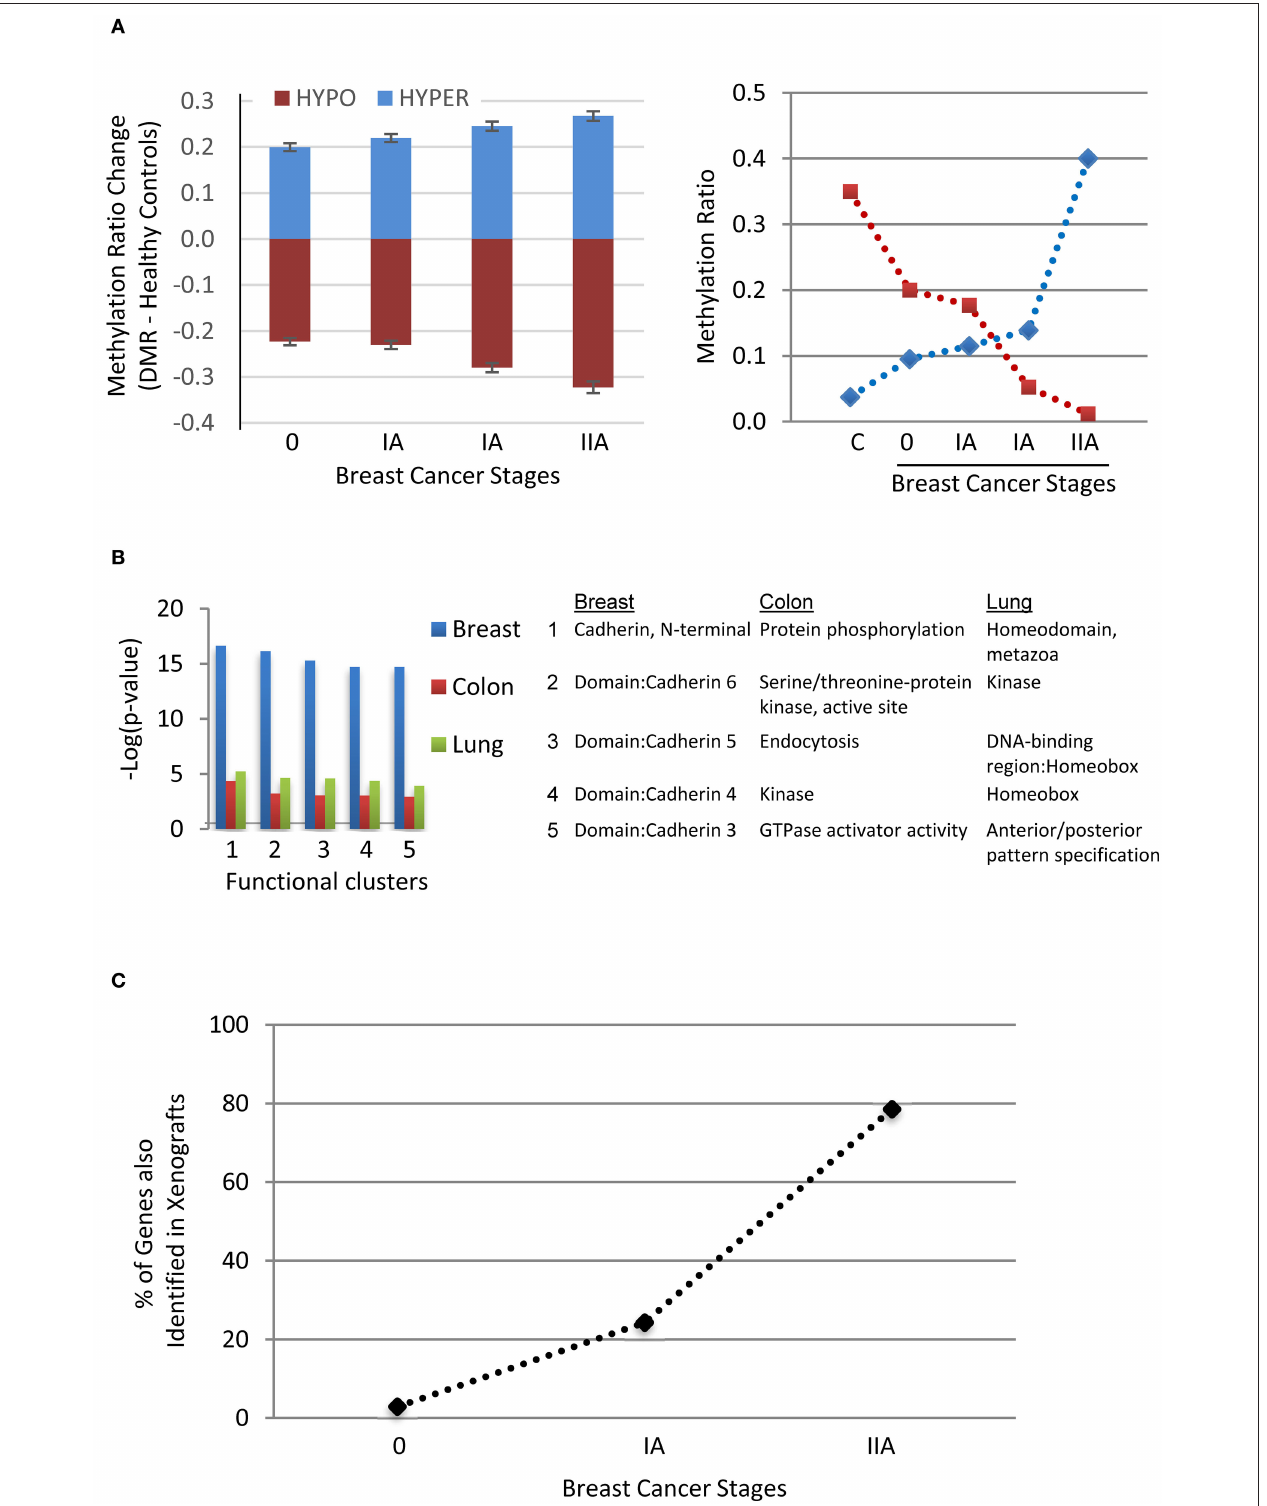
FIGURE 5 | Evidence supporting the association of the DMRs with tumorigenesis. (A) Stage-dependent methylation changes of breast cancer-specific DMRs (Mean ± SEM, n = 314, Left panel) compared to the mean of healthy controls (C) and two examples of hyper- or hypo- methylation from stage 0 to stage II with two samples at stage IA. (B) Top five DAVID functional clusters of the cancer-specific DMR-associated human genes of the three types of cancers. (C) Percentages of identified genes shared ( n = 34) between the human breast cancer and xenograft tumor samples among the three stages of breast cancer.